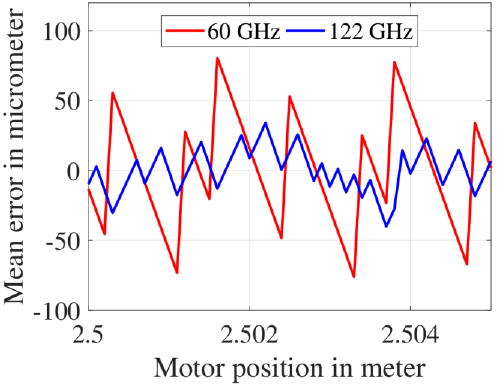
Figure 8. Mean distance measurement error after the first CZT iteration.